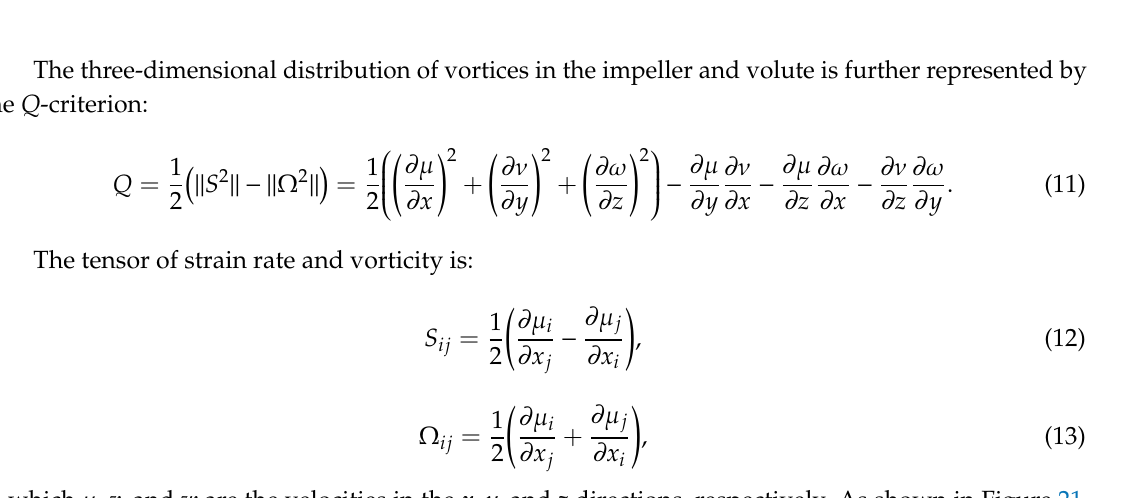
= 0.483: ( A ) model-A; n